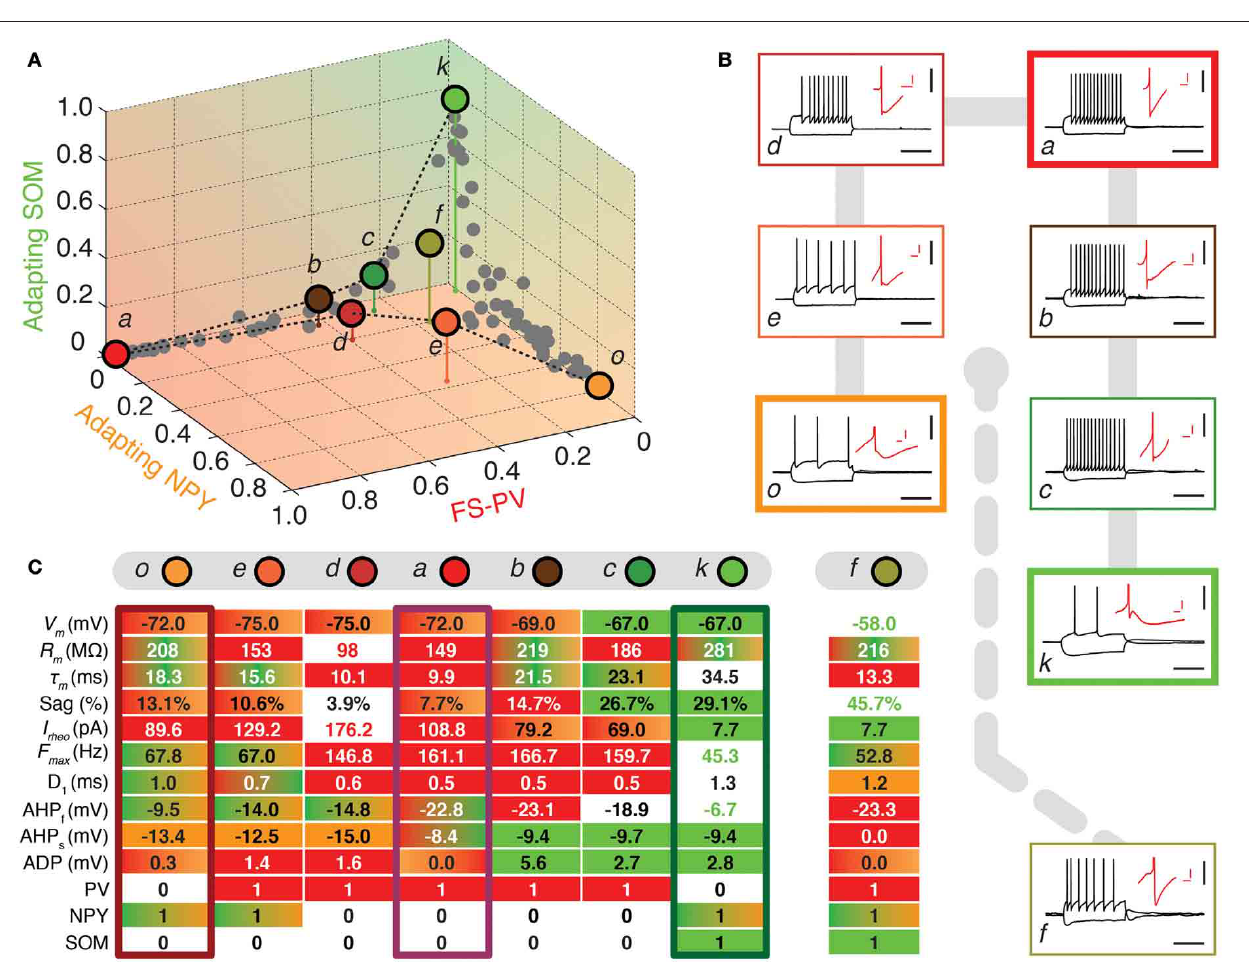
first spike (red traces, scale bars 5mV, 20ms). (C) Table summarizing 10 electrophysiological and 3 molecular discriminative properties of transition cells between the Adapting NPY, the Adapting SOM, and the FS-PV archetypes. Orange, green, and red backgrounds indicate distinctive values for the Adapting NPY, the Adapting SOM, or the FS-PV archetype, respectively. Gradient backgrounds indicate values falling in a range typical for multiple. Bold colored entries indicate extreme values for an archetypal trend. Thick contours highlight columns corresponding to archetypal cells. Atypical cells display a heterogeneous mixture of property values which are not compatible with a single archetype or which fall in transition